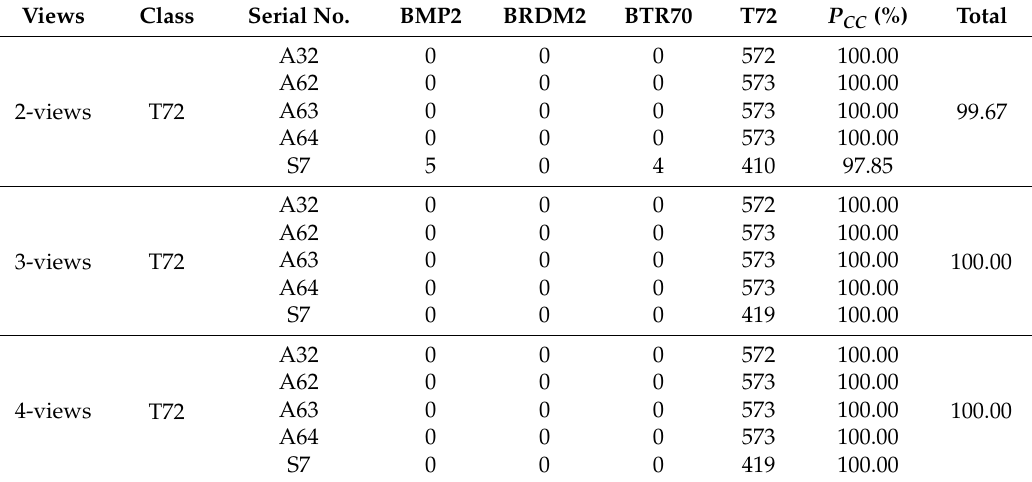
Table 10. Confusion Matrix of the MS-CNN under EOC-2 (version variants).